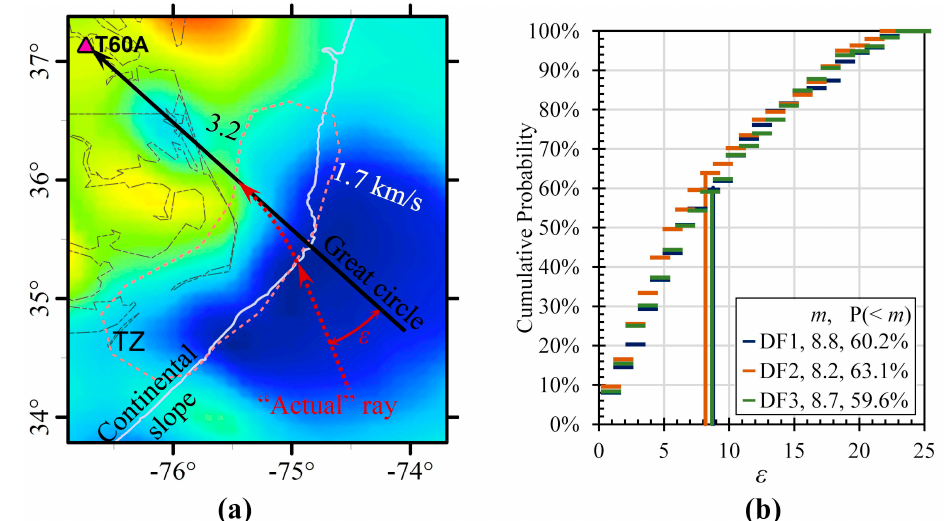
Figure 11. ( a ) Defining angle ε to measure total refraction of Rayleigh wave ray passing through the transitional zone (TZ in Figure 9a,c) taking a ray path to station T60A as an example. The black solid and red dotted lines are the great circle projected in this study and “actual” ray path of Rayleigh wave, respectively. ( b ) Cumulative probability of ε for waves in the three DF bands propagating through TZ.